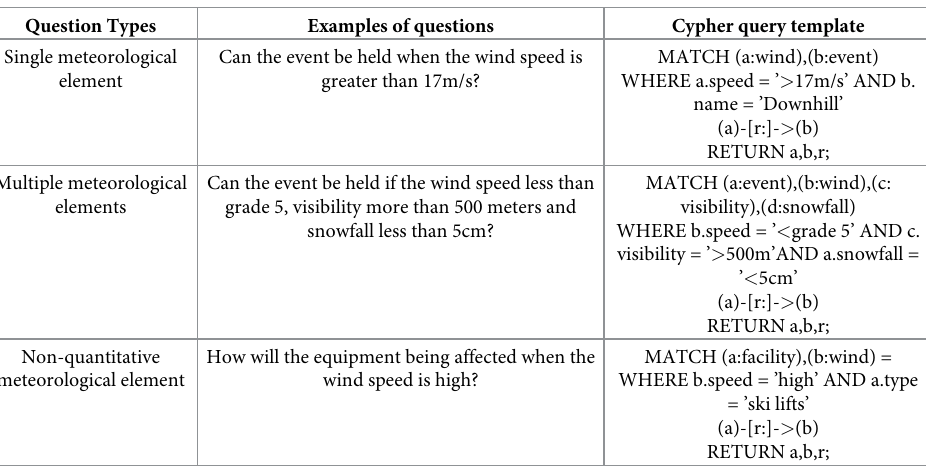
Table 7. Different types of